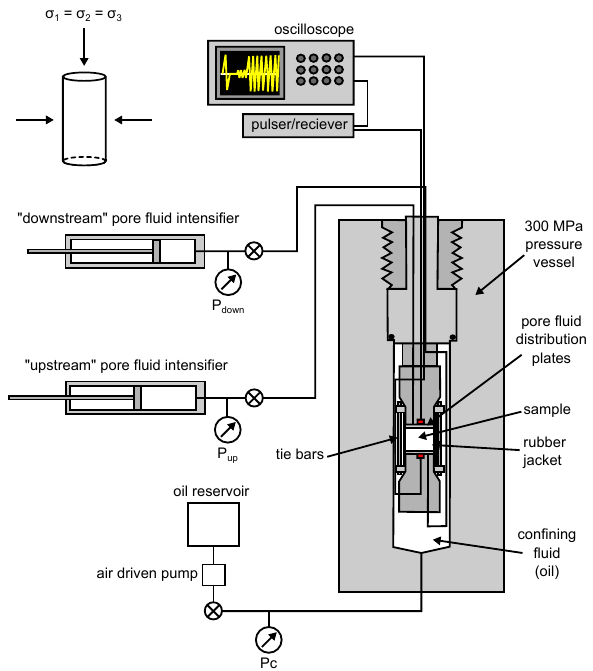
Fig. 3. Schematic diagram of the permeameter at the Rock & Ice Physics Laboratory (RIPL), University College London. Schematic is not to